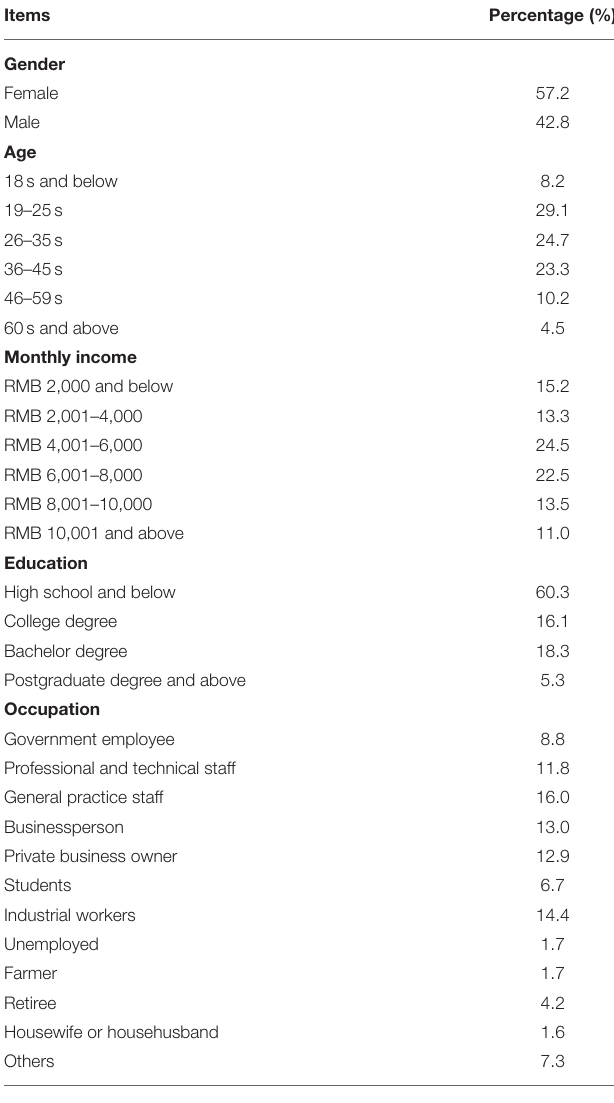
TABLE 1 | Demographic characteristics of the sample ( N =